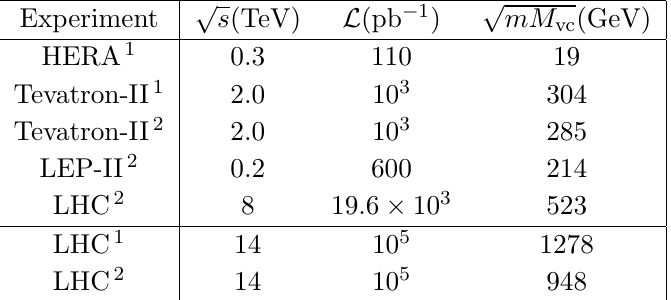
p s means the centre of mass p mM vc is the p 2 mM vc [70, 71].